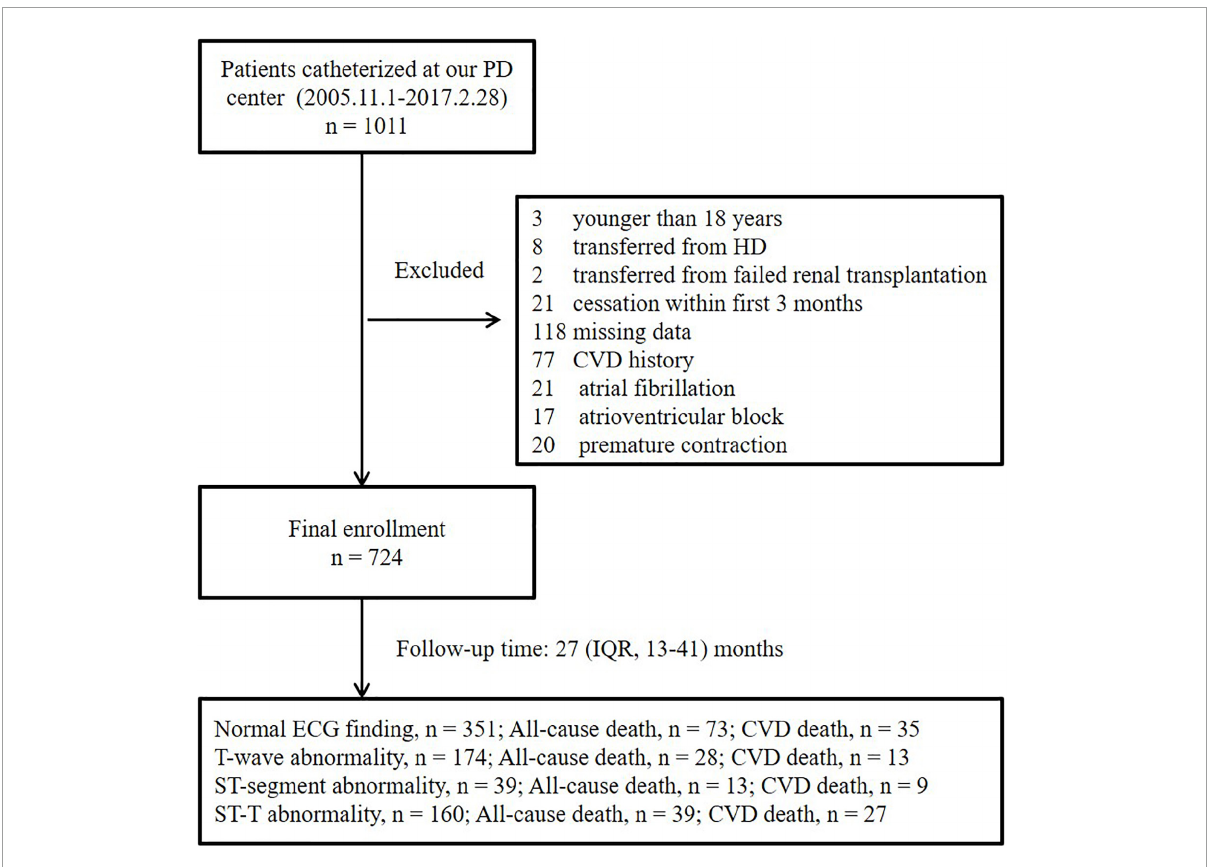
FIGURE1 Enrollment flowchart. PD, peritoneal dialysis; HD, hemodialysis; IQR, interquartile range; ECG, electrocardiogram; CVD, cardiovascular